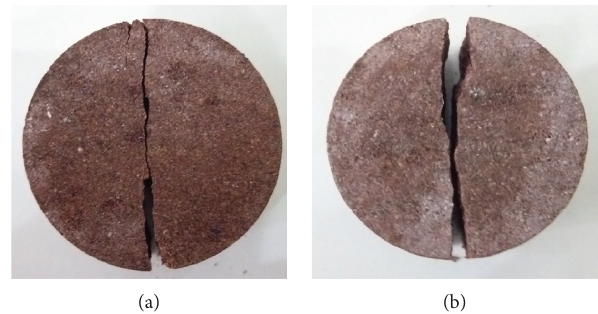
Figure 9: The typical failure mode of the specimens under strip loading. (a) No. 1-26. (b) No. 1-24.